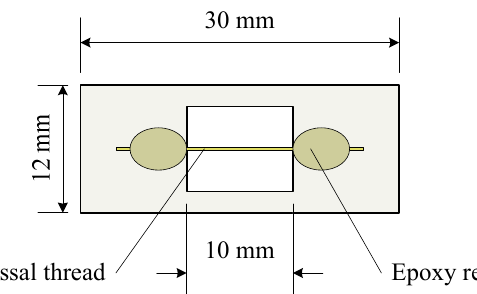
Fig. 4 Procedure for application of tension to a byssal thread.